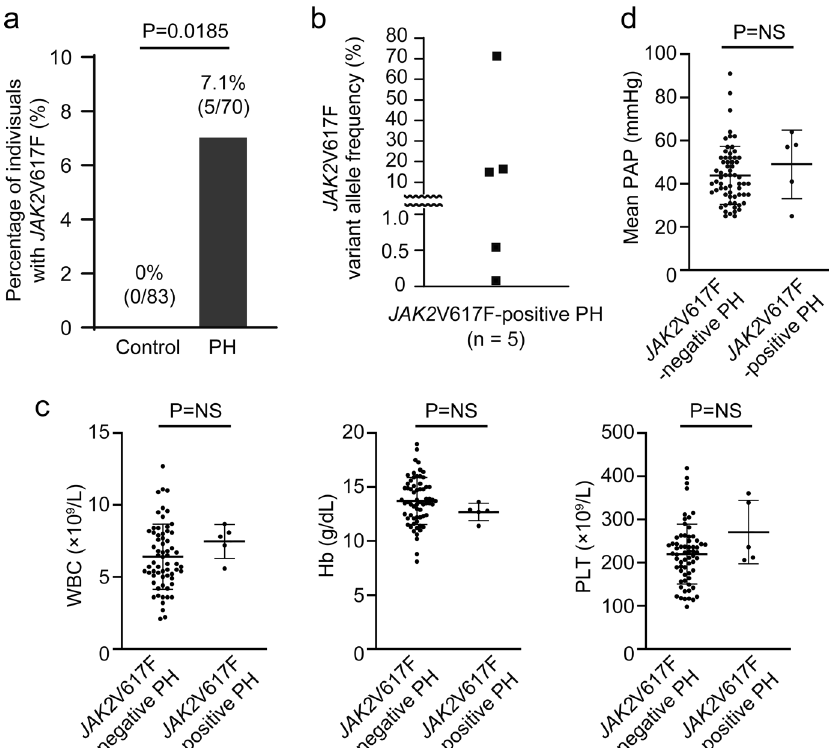
Fig. 9 Prevalence of JAK2 V617F-positive clonal hematopoiesis in PH patients. a JAK2 V617F-positive clonal hematopoiesis was more common in PH patients. The comparison between PH patients ( n = 70) and age- and sex-matched control subjects ( n = 83) was made by Fisher ’ s exact test (two-sided). b JAK2 V617F variant allele frequency. c , d , Peripheral blood cell counts, and mean PAP (pulmonary arterial pressure) evaluated by right heart catheterization between JAK2 V617F-negative and JAK2 V617F-positive PH patients ( n = 64, 5 for WBC, Hb, PLT and n = 63, 5 for mean PAP). d . Data are presented as mean ± SD. Comparisons of values between the two groups were performed by the unpaired Student ’ s t -test (two-sided). WBC white blood cell count, Hb hemoglobin concentration; PLT platelet count, NS not signi fi cant. Source data are provided as a Source Data fi